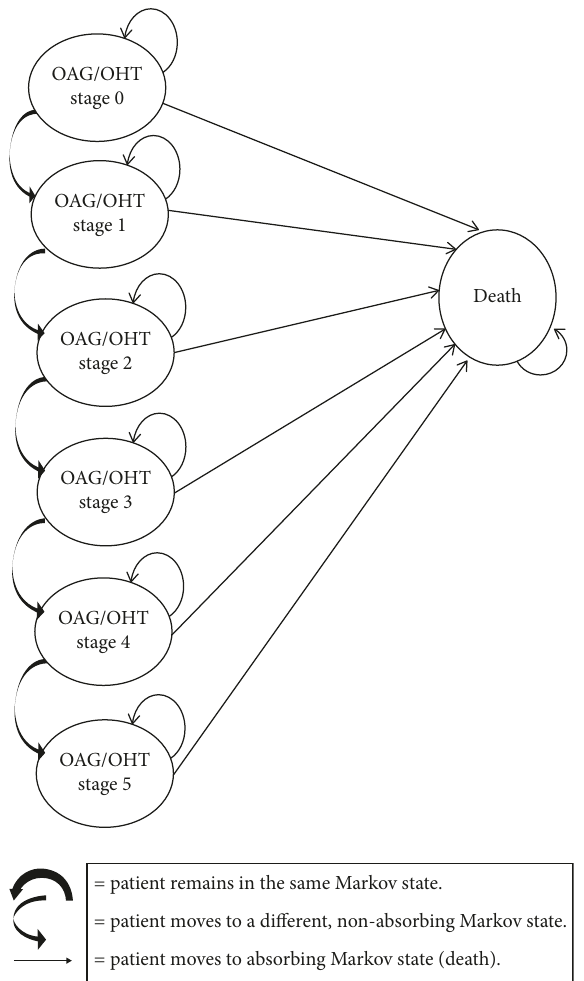
Figure 1: Markov model. OAG/OHT ocular